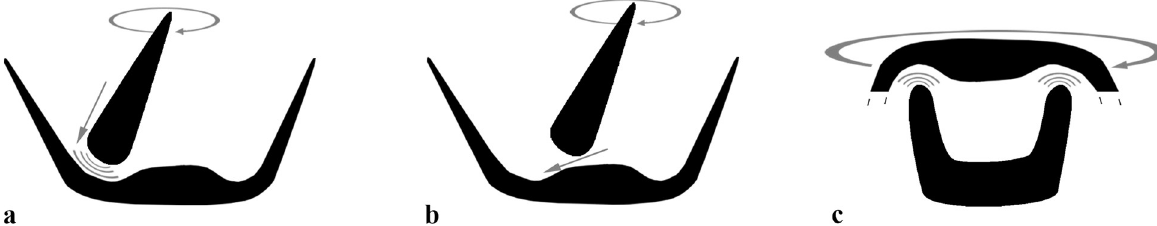
Fig 14. Schematic representations of the hypothetical mechanisms related to the circumferential depression. (a) Using the vessel wall as a retaining barrier for a tool while processing a material inside the vessel; (b) Restricting the tool use within the base perimeter, which facilitates the rotation and confines the distribution of the wear; (c) Forming the circumferential depression due to the vessel use as a turntable.